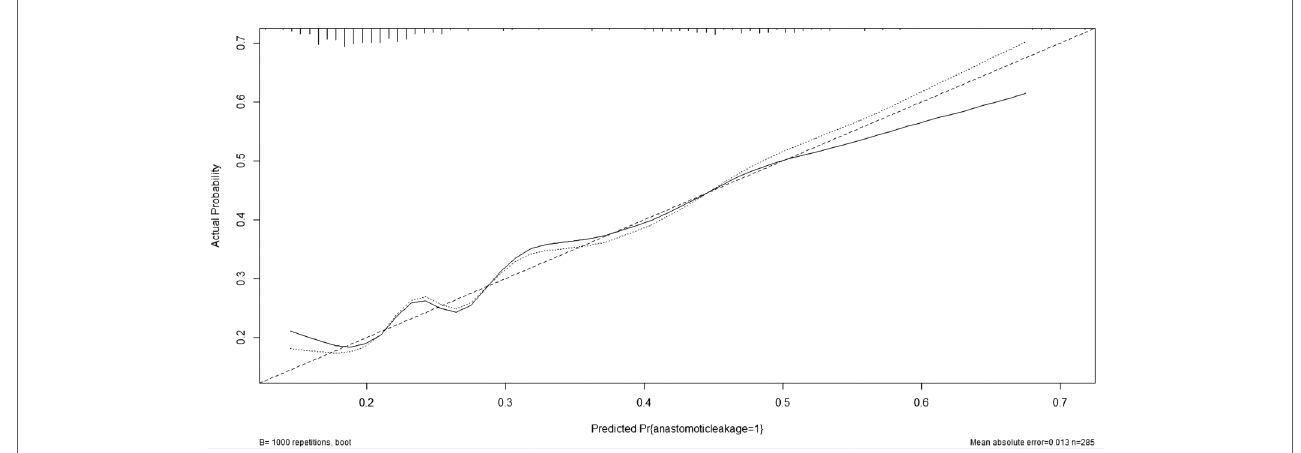
FIGURE 4 The accuracy of the model for identifying patients with AL was determined using AUC analysis.